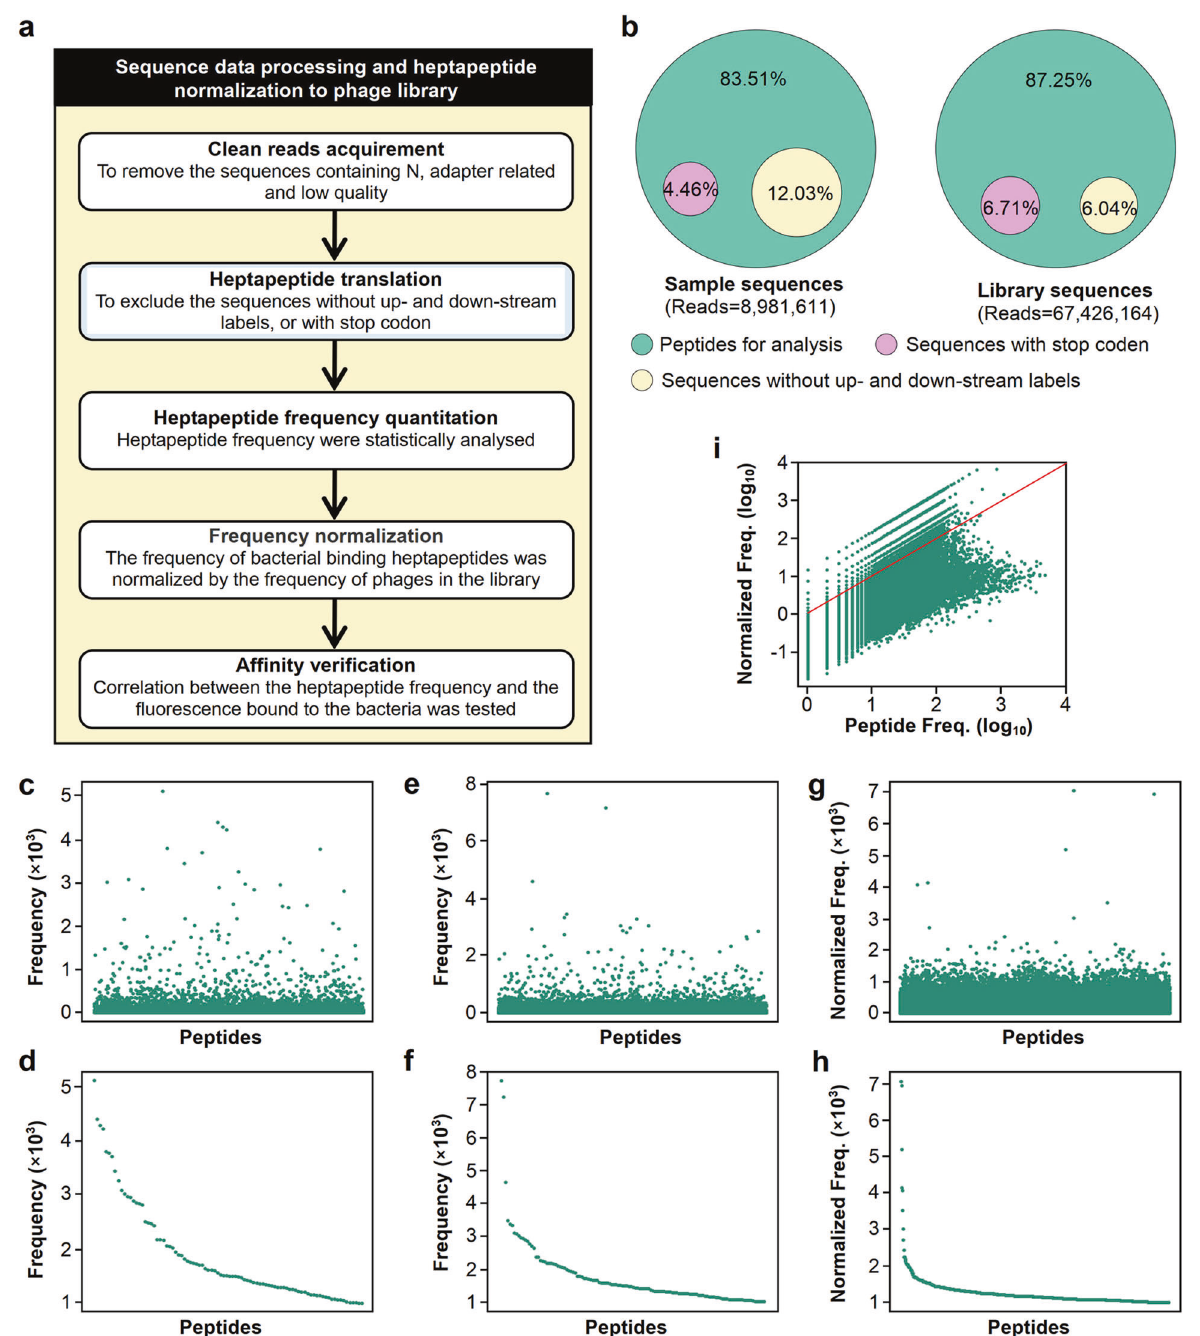
Fig. 3 Frequency calibration for heptapeptides binding to the lethal bacterial strain MSI001 . a Flowchart for sequence data processing and heptapeptide normalization to the phage library. b Sequence composition of recovered samples and phage library inputs. Peptides for analysis were acquired by removing the sequences with stop codons or without up- and/or down-stream labels. c Randomized frequency distribution for the binding heptapeptides. d Descending frequency distribution for the binding heptapeptides with frequencies above 1000. e Randomized frequency distribution for the heptapeptides encoded by the phage library. f Descending frequency distribution for the library heptapeptides with frequencies above 1000. g Normalized frequency distribution for binding heptapeptides. The frequency of each binding heptapeptide was divided by the frequency of the corresponding heptapeptide encoded by the phage library to acquire the normalized frequency of binding heptapeptides. h Descending frequency distribution of binding heptapeptides with normalized frequency higher than 1000. i Logarithmic distribution of unnormalized and normalized heptapeptide frequencies. The frequency of all peptides except those on the red line were adjusted after normalization